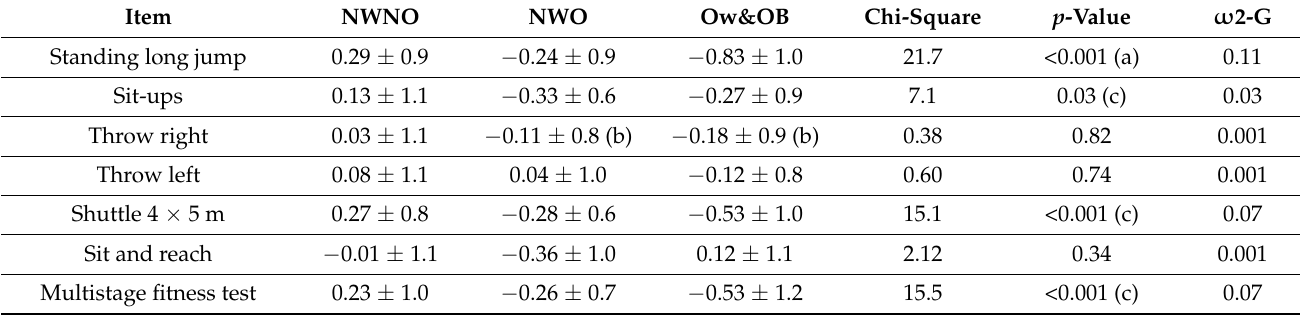
Table 4. Physical fitness performance of NWO NWNO and Ow&Ob children considering